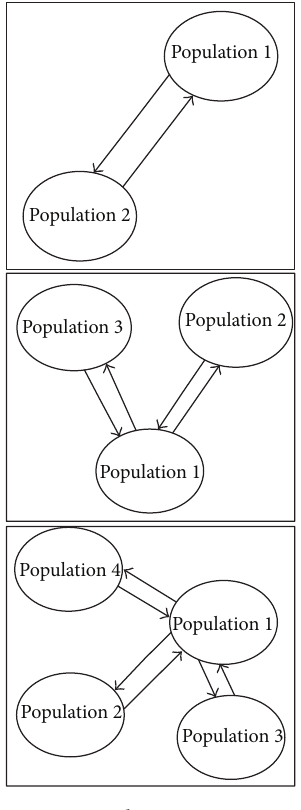
Figure 5: Simulation